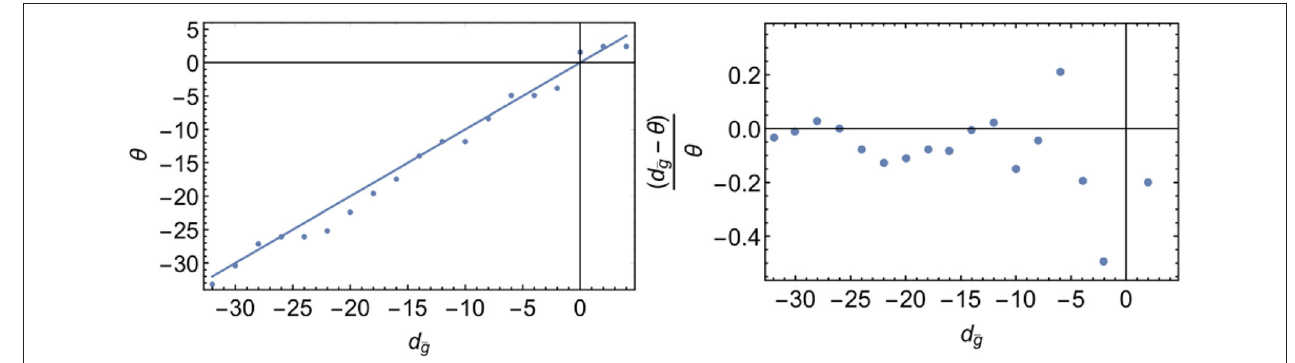
n , compared to the canonical n √ gR P